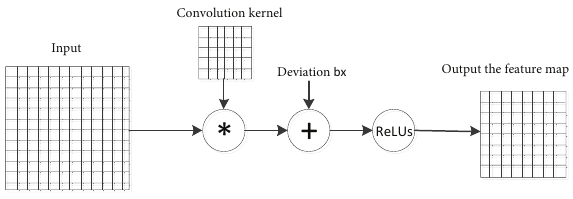
Figure 5. Process of convolution operation.